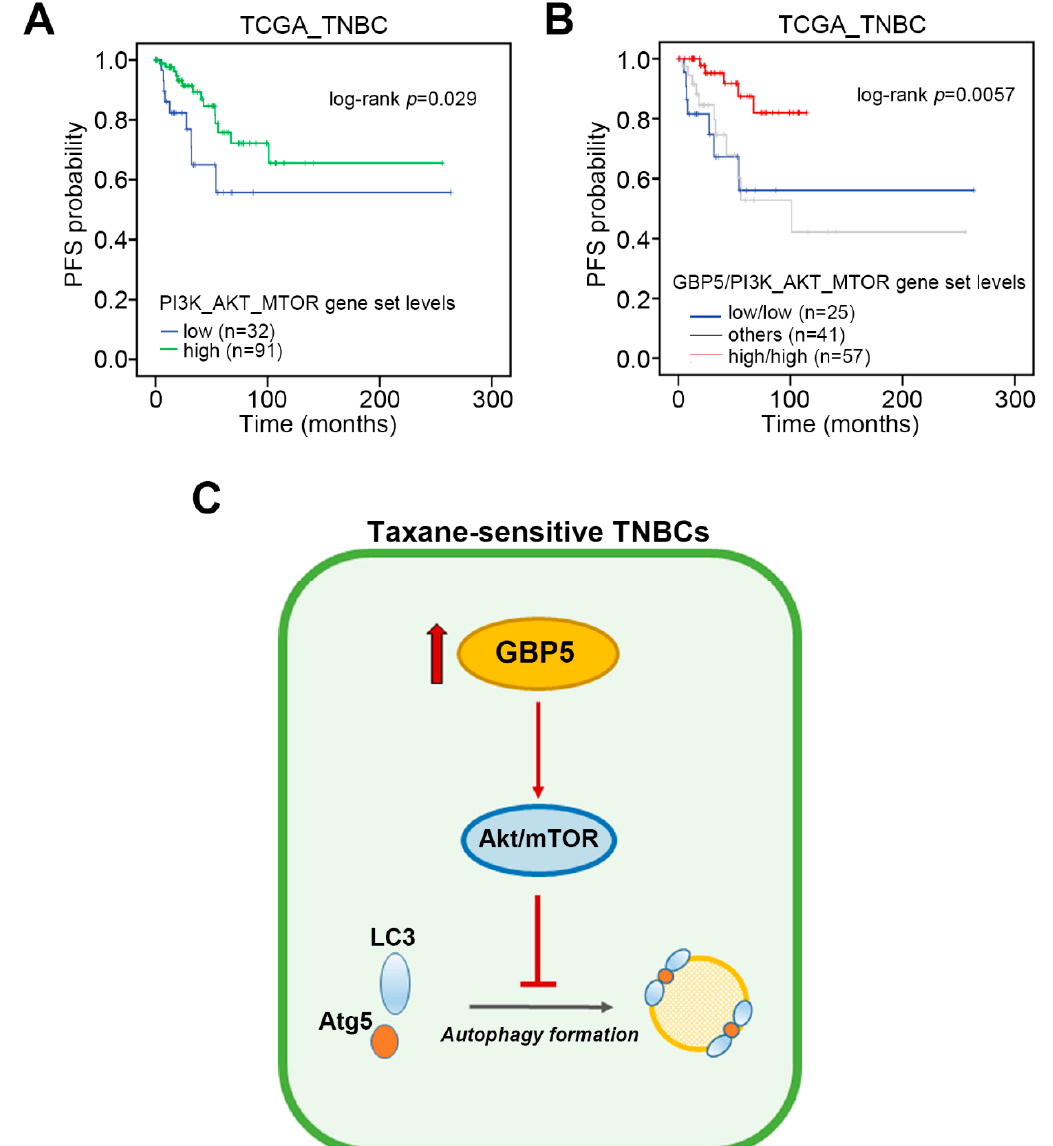
Figure 6. The signature of combining higher levels of GBP5 and PI3K_AKT_MTOR gene set correlates with a favorable progression-free condition in TNBC patients. ( A , B ) Kaplan–Meier analyses for the expression of PI3K_AKT_MTOR gene set without ( A ) or with ( B ) the combination of GBP5 expression using progression-free survival condition under a minimized log-rang p value against TCGA TNBC patients. ( C ) A possible mechanism for the GBP5-enhanced taxane sensitivity in TNBC.